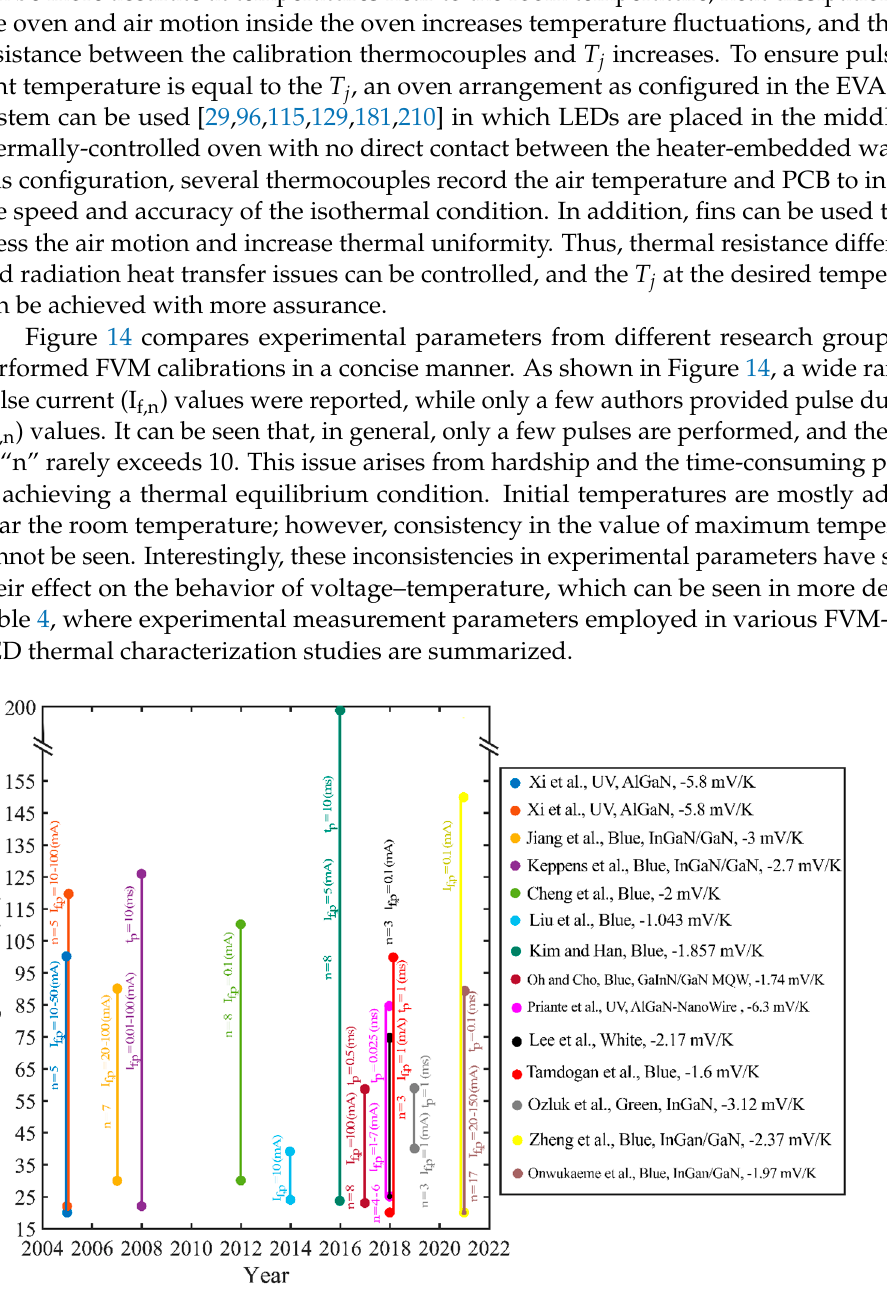
Figure 14. A yearly summary of the employed oven temperature ranges for the calibration of FVM from different research groups. I f,p represents the applied pulse current, t p represents the duration of the applied pulse current, and n stands for the number of temperature points set for the calibration measurement within the given oven temperature interval. The legend provides author indications (oldest to most recent from top to bottom), studied device types, and k-factors obtained from the pulses with a minimum value of I f,p . Each colored line indicates the temperature difference between T p,1 and T p,n . References from top to bottom are Xi et al. [62], Xi et al. [64], Jian et al. [186], Keppens et al. [184], Cheng et al. [114], Liu et al. [203], Kim and Han [190], Oh and Cho [196], Prinate et al. [94], Lee et al. [111], Tamdogan et al. [164], Ozluk at al. [115], Zheng et al. [145], and Onwukaeme Physical